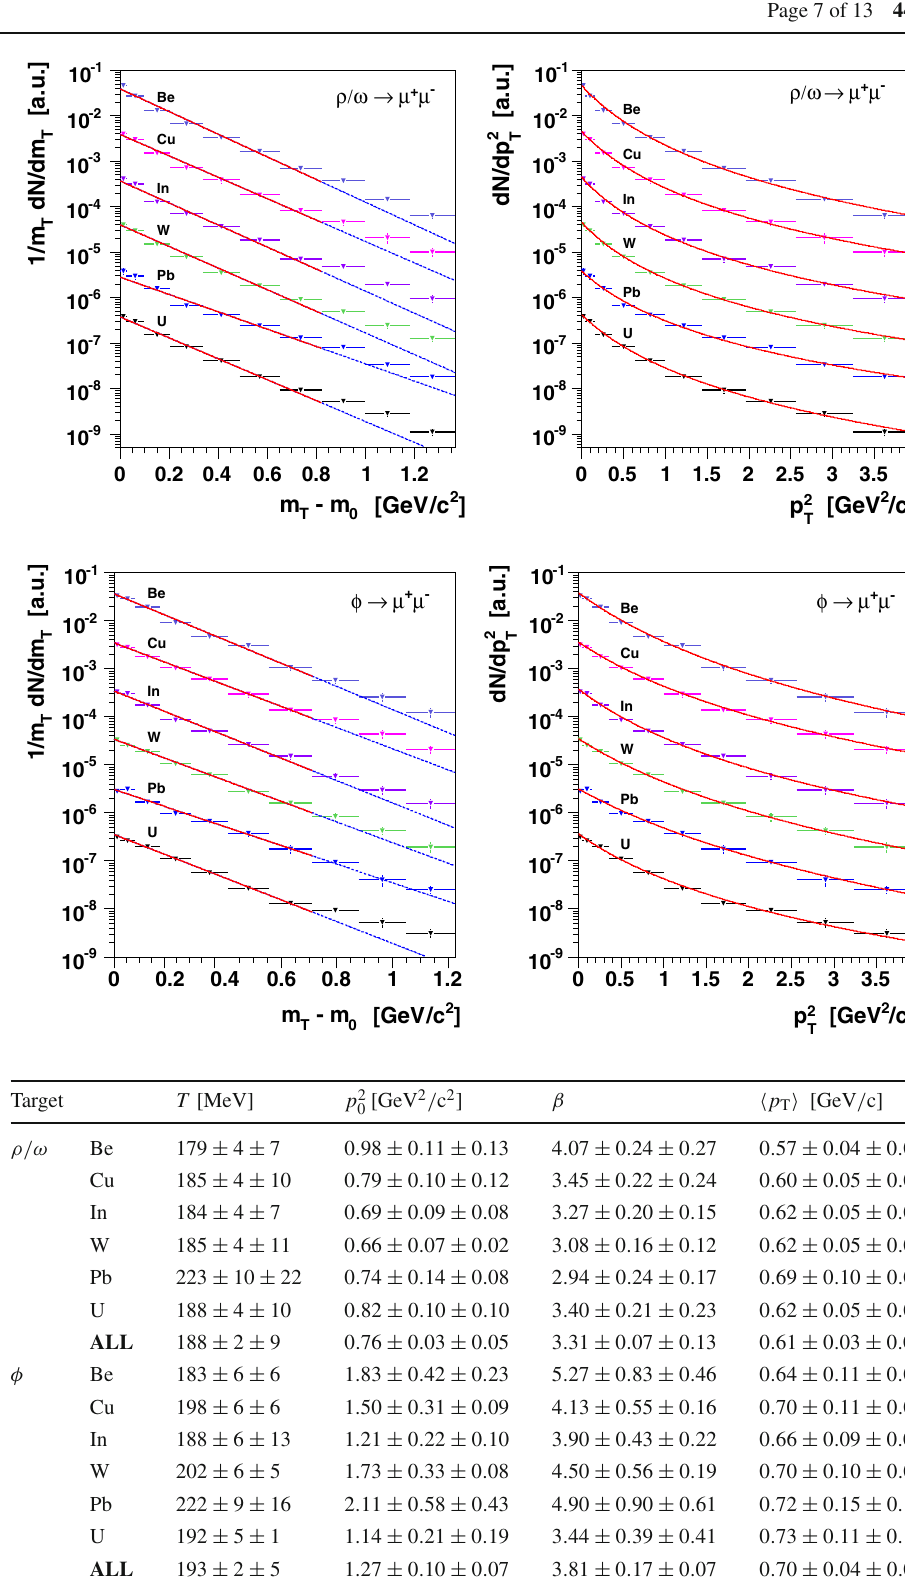
Fig. 2 Left: fits on the acceptance-corrected m T spectra of the ρ/ω mesons, with the exponential function (4). Right: Fits on the acceptance-corrected p 2 spectra of the ρ/ω mesons, T with the power-law (5)